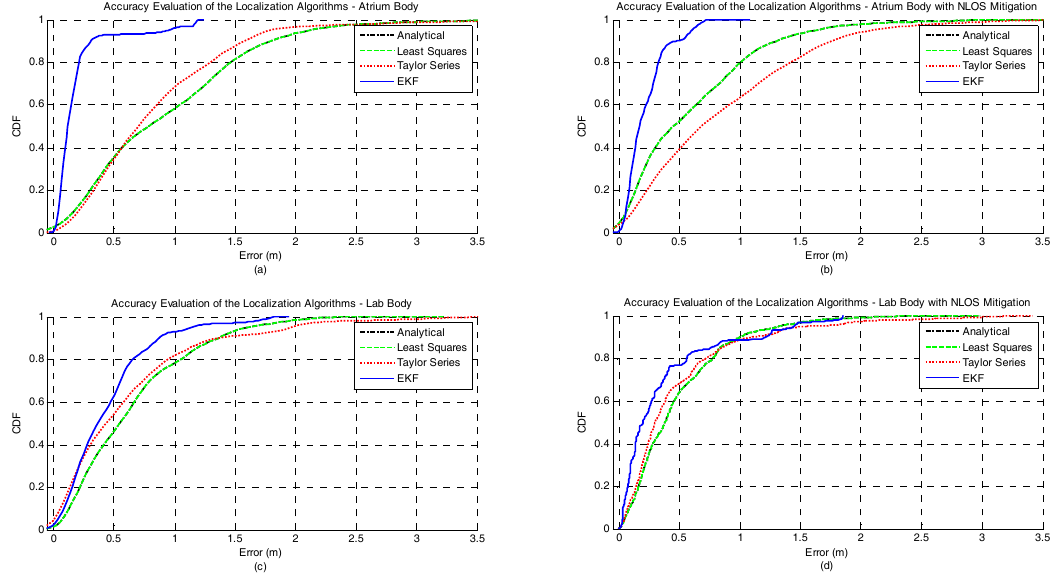
Figure 6. Comparison of the accuracy achieved by each algorithm for static nodes with human body interference and with or without NLOS mitigation. The first row represents the accuracy achieved by each algorithm in atrium with ( a ) and without ( b ) NLOS mitigation. Whereas, the second row represents the accuracy achieved by each algorithm in lab with ( c ) and without ( d ) NLOS mitigation.